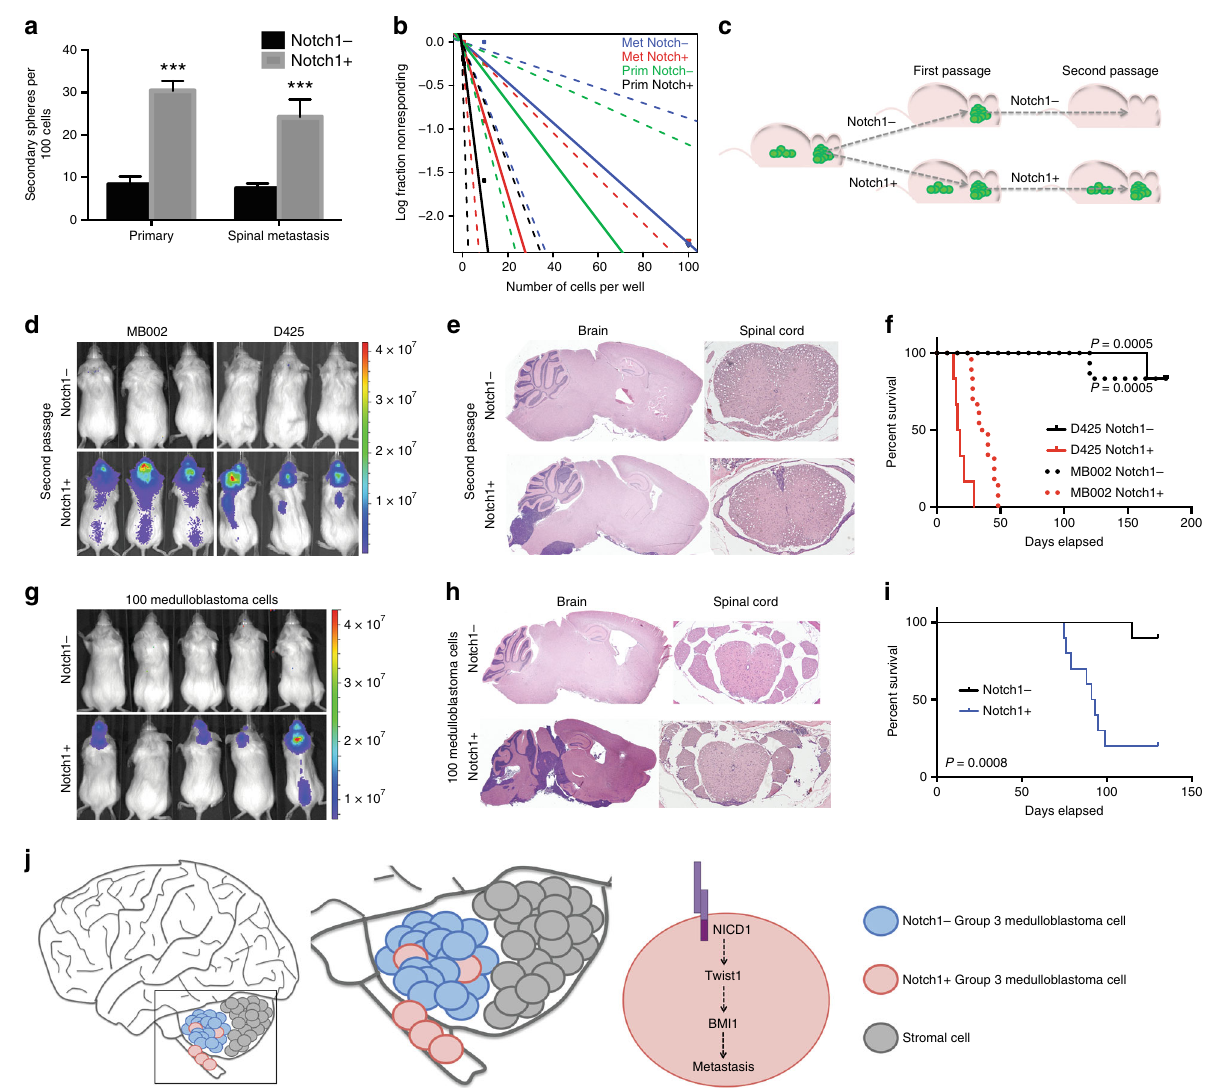
Fig. 3 NOTCH1 + cells promote Group 3 medulloblastoma self-renewal. a In vitro extreme limiting dilution assays comparing the frequency of tumorsphere formation between NOTCH1 − and NOTCH1 + Group 3 medulloblastoma cells isolated from primary tumors and spinal metastases. *** P < 0.001, Mann – Whitney U test. b Quantitative analysis of the frequency of colonies formed by NOTCH1 − and NOTCH1 + Group 3 medulloblastoma cells isolated from primary tumors and spinal metastases. ELDA software (http://bioinf.wehi.edu.au/software/elda/) was used to calculate medulloblastoma stem cell frequency and assess statistical signi fi cance. Prim NOTCH1 - (green) versus Prim NOTCH1 + (black) ( P = 0.02) and Met NOTCH1 − (blue) versus Met NOTCH1 + (red) ( P = 0.04). c Scheme of NOTCH1 − and NOTCH1 + in vivo sorting and passages. d Bioluminescence imaging and hematoxylin/eosin staining of brains and spines ( e ) from mice injected with the second in vivo passage of NOTCH1 − or NOTCH1 + sorted from primary tumors generated by MB002 and D425. f Kaplan – Meyer survival curves of mice injected with the second in vivo passage of NOTCH1 − and NOTCH1 + in two models (MB002 and D425). P -values are from log-rank test. Bioluminescent imaging ( g ), hematoxylin/eosin staining of brains and spines ( h ), and survival curves ( i ) from mice injected with 100 NOTCH1 − or NOTCH1 + medulloblastoma cells (D425). j Proposed model: NOTCH1-induced medulloblastoma metastasis occurs trough the activation of the NICD1-TWIST1-BMI1 axis. Error bars, upon histopathology analysis by institutional, board-certi fi ed neuropathologists prior to further analysis. Medulloblastoma samples were enzymatically dissociated to single cells by collagenase IV (1 mg mL − 1 ) and DNase I (250 units mL − 1 ) and cells were plated in neural stem cell expansion media (NSCEM) consisting of Neurobasal (-A) (Invitrogen), B27(-A) (Invitrogen), human-bFGF (20 ngmL − 1 ) (Shenandoah Biotech), human-EGF (20 ngmL − 1 ) (Shenandoah Biotech), human recombinant LIF (Millipore) (as required) and Heparin-sulfate (10 ngmL − 1 ). Cells were grown for two passages and infected with EF1-GFP-T2A-Luciferase (Systems